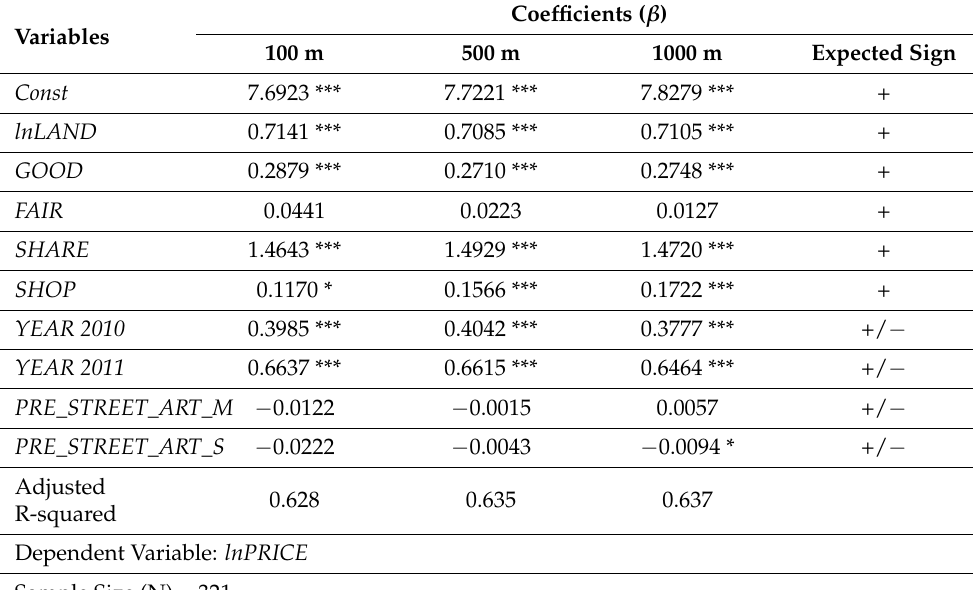
Table 7. OLS Regression Results of Model 4.